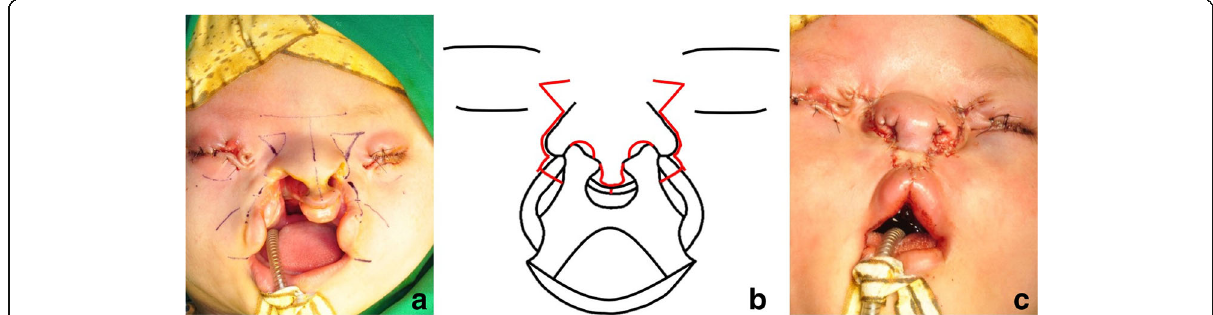
Fig. 3 Intraoperative photographs and the schematic design. a Incision lines were marked on the prolabium, alar bases, lateral lip segments, and peri-orbital area, after tattooing anatomical landmarks such as peak points for the Cupid ’ s bow, alar base, nasion, real and expected medial canthus, and mouth corners. b The schematic design of surgical incisions. c All the sutures are done